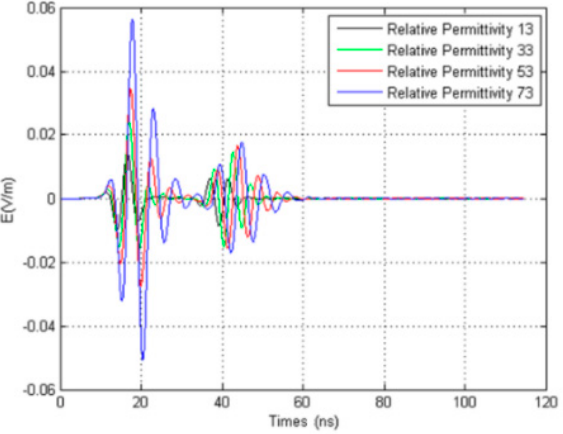
ff erent dielectric constants of fluids in boreholes (Figure Figure 6. Comparisons of different dielectric constants of fluids in boreholes (Figure 2b). Figure 6. Comparisons of di